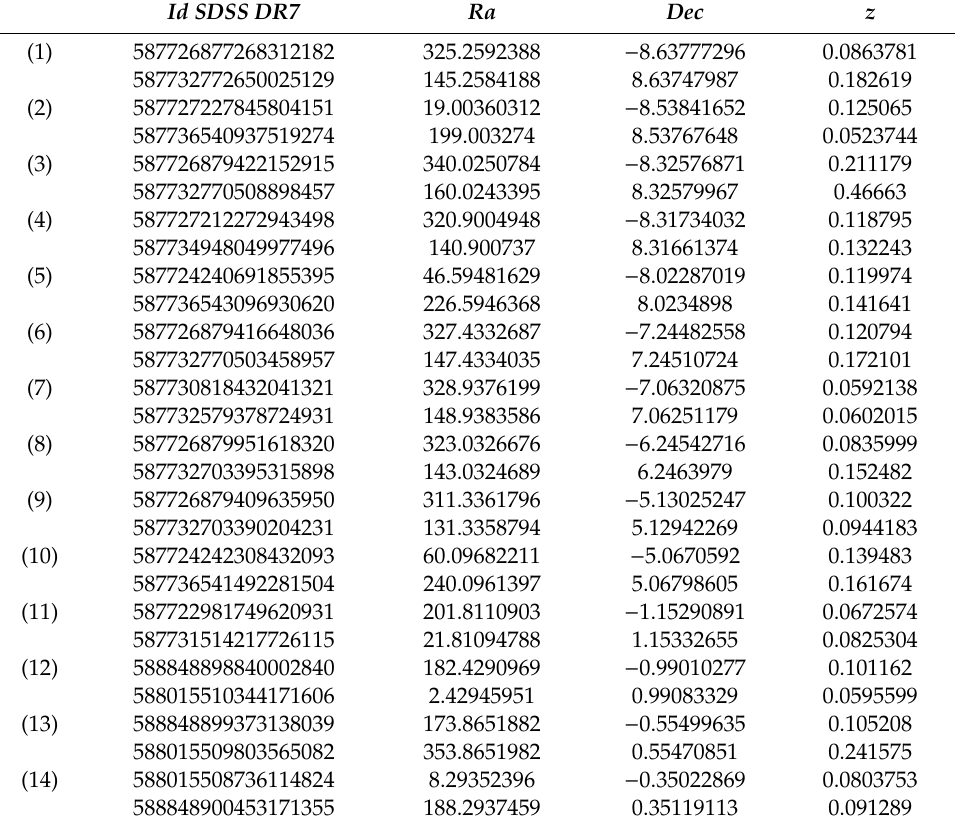
Table A3. Pairs of opposite galaxies for the e ff ect of cosmic mirror [36]—alternative approach. Id SDSS DR7 is objID identification number in the Sloan Digital Sky Survey. Accuracy is of 0.001 ◦ for ra and dec and z / 2 for z